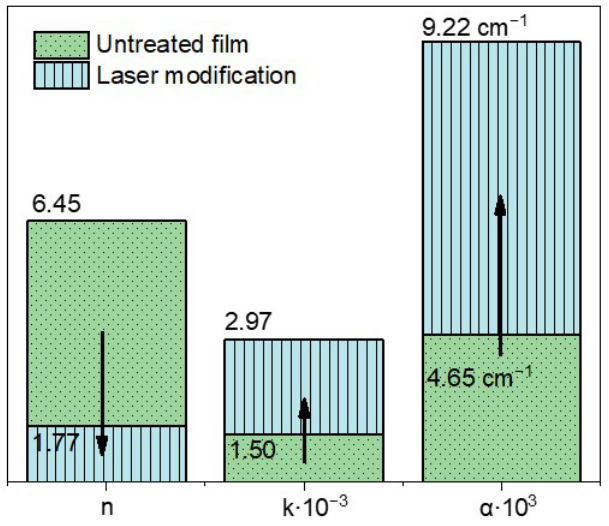
Figure 7. PbSe films optical characteristics at a wavelength 405 nm for untreated film (green) and film after laser modification (cyan): refractive index n , extinction coefficient k, absorption coefficient α